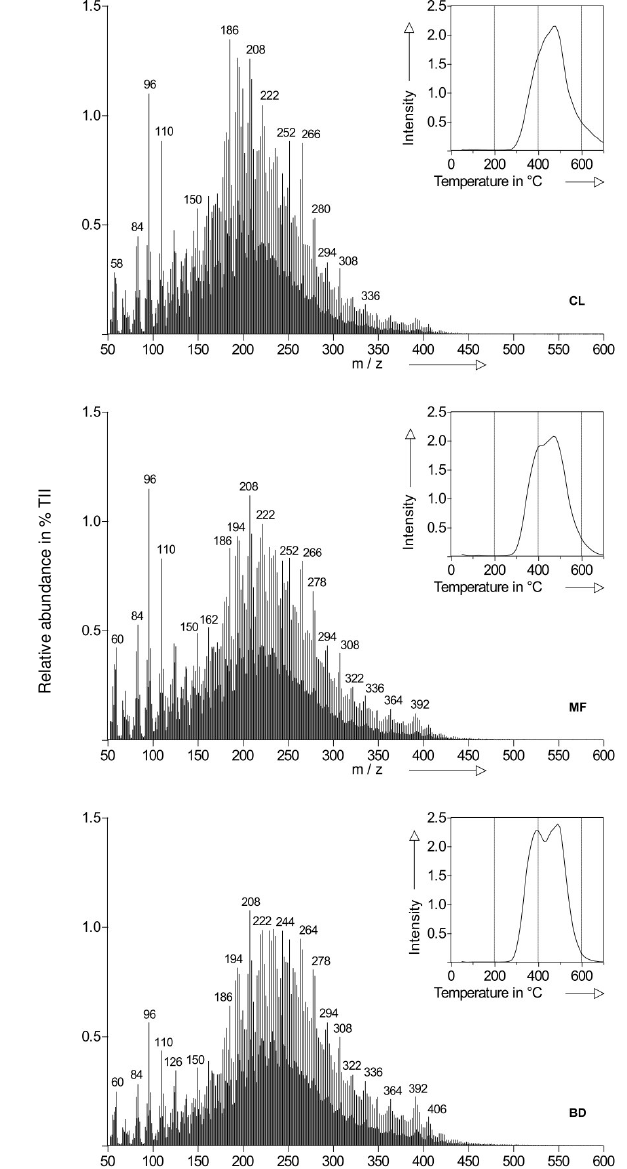
Figure 4. Thermograms of total ion intensity (TII, upper right in- sets) and summed pyrolysis-field ionisation mass spectra of the treatments (CL, control; MF, mineral fertiliser; BD, biogas diges- tate) before tillage.